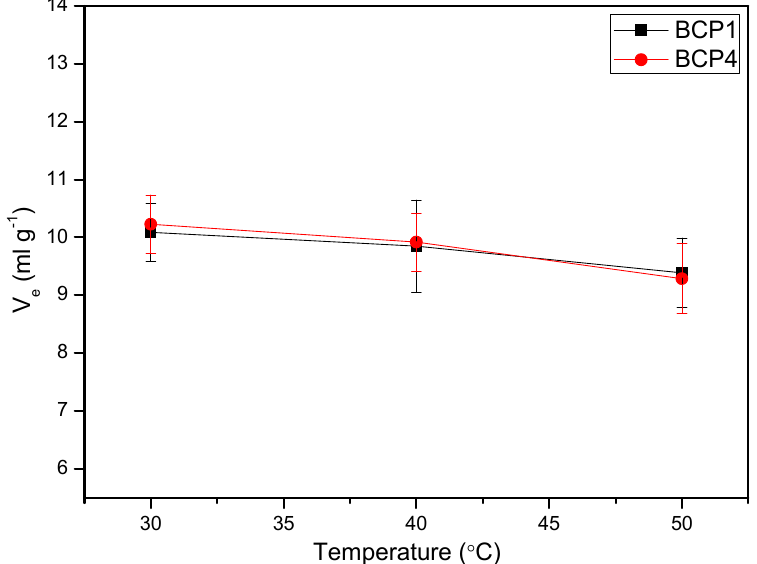
Figure 8. Effect of temperature on the equivalent hydrodynamic volume of copolymers BCP-1 and BCP-4 in DMF.